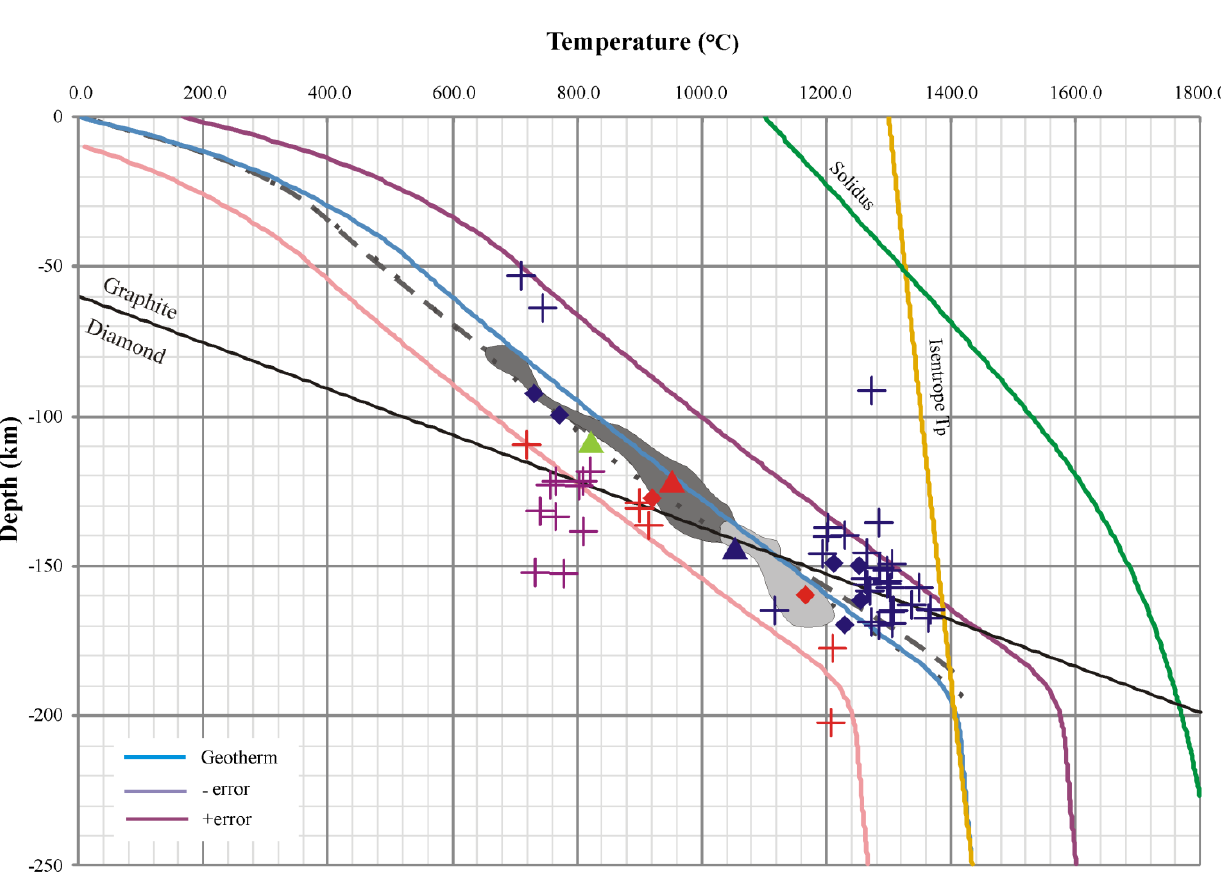
Figure 8. Pressure and temperature values calculated for xenoliths using the equation Nimis and Taylor [23] (NT2000): Garnet lherzolite (diamonds) and phlogopite garnet wehrlite (triangles); and for single clinopyroxene macrocrysts (cross) from the TZ (purple), CA (red), AC63 (green) and CU79 (blue) kimberlites. Paleogeotherm calculated using FITPLOT program (blue line, with pink and purple lines representing the error envelope). P-T data calculated from mantle xenoliths from the Bultfontein kimberlite (dark gray shading) and paleogeotherm (dark gray dashed line); and P-T data calculated from mantle xenoliths from the Finsch kimberlite (light gray shading) and paleogeotherm (light gray point line) after Mather et al.